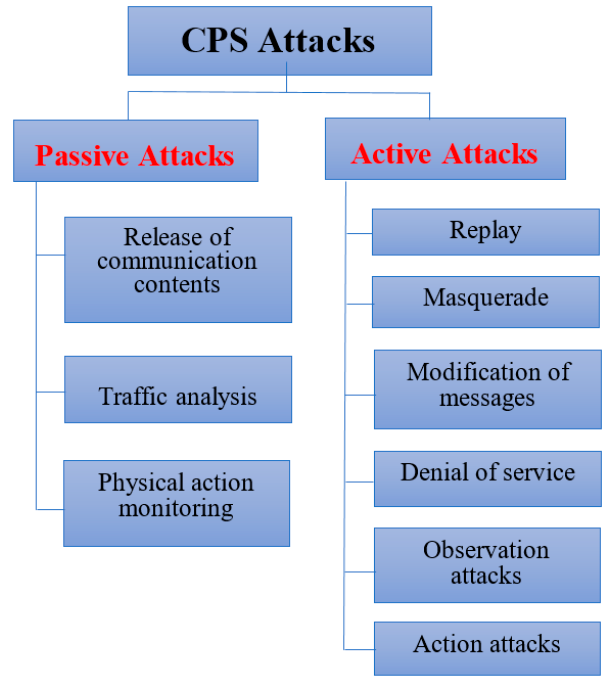
Figure 3. General CPS Attacks.